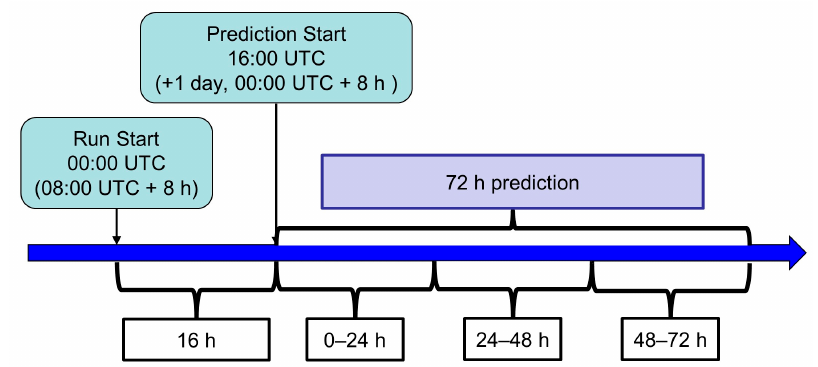
Figure 3. WRF model running time for the wind power forecasting of wind farms in China.